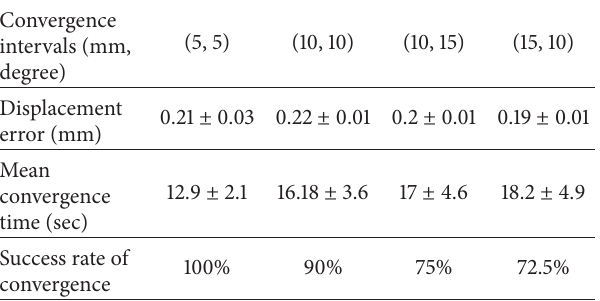
Table 1: Convergence results of different convergence interval.